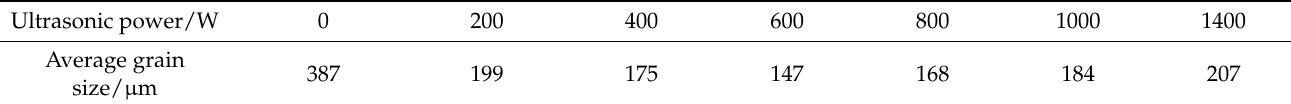
Table 3. Effect of ultrasonic power on the grain size of the AZ80